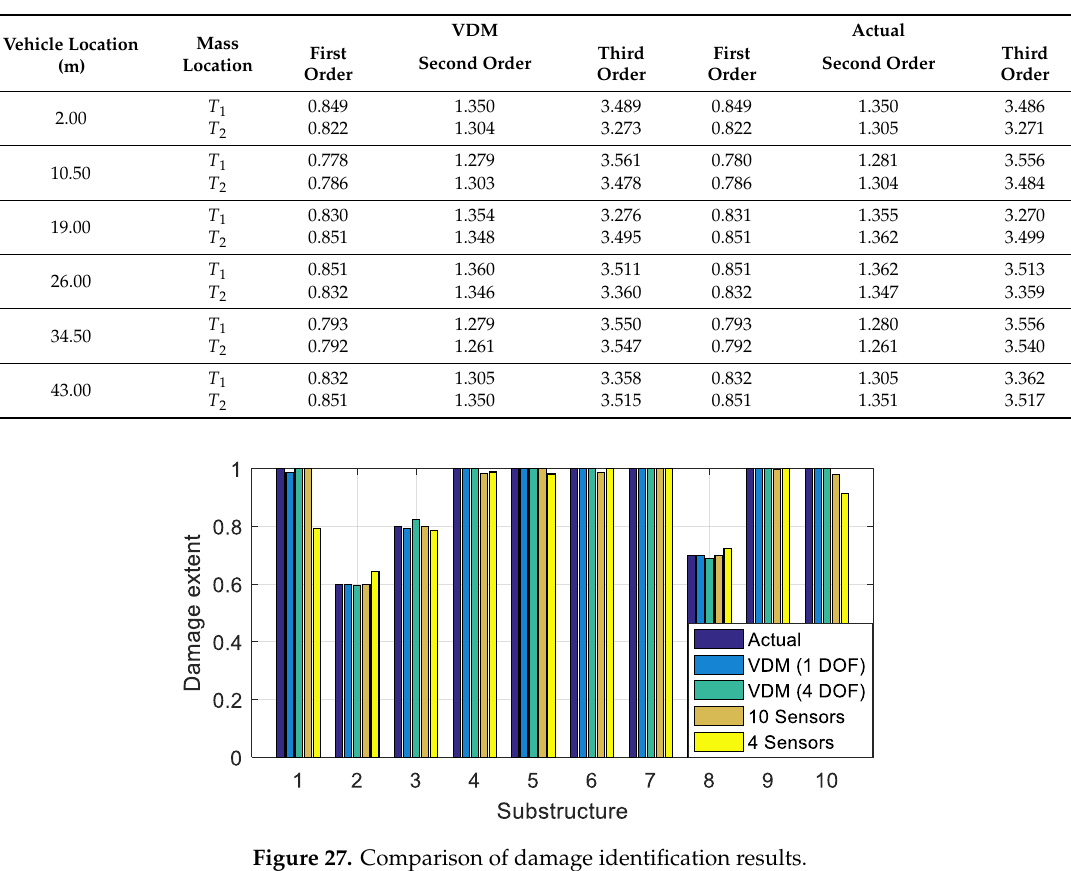
Figure 26. Acceleration frequency responses at T 2 wheel position with the virtual mass added to the wheel T 2 .